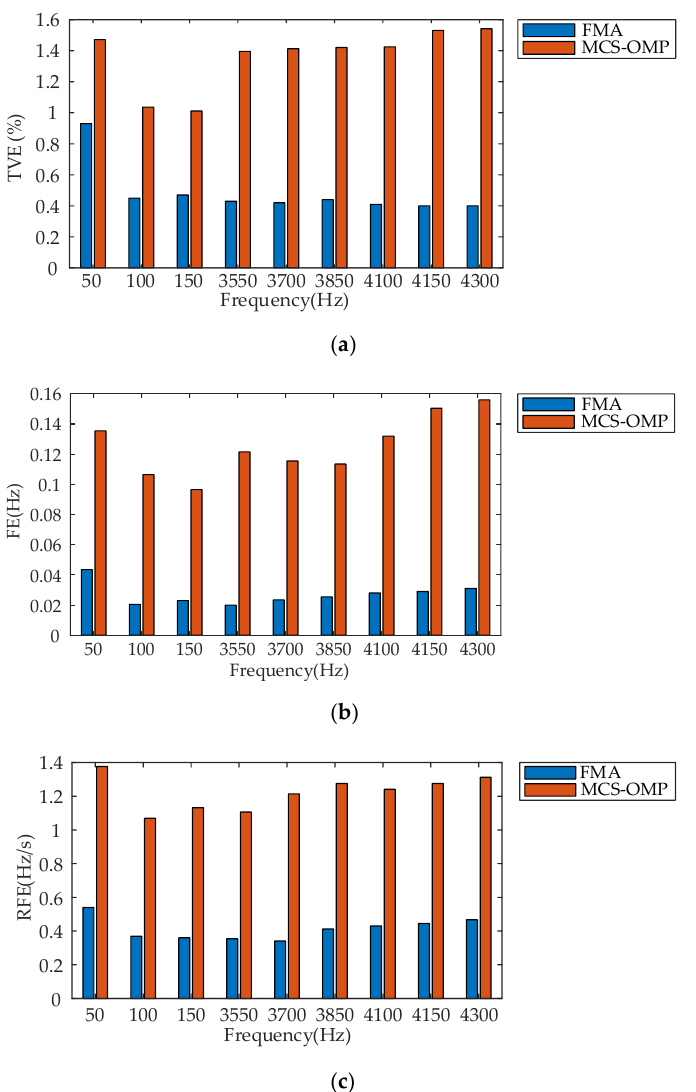
Figure 4. Wide-frequency noise test results: ( a ) TVE values for each algorithm; ( b ) FE values for each algorithm; ( c ) RFE values for each algorithm.